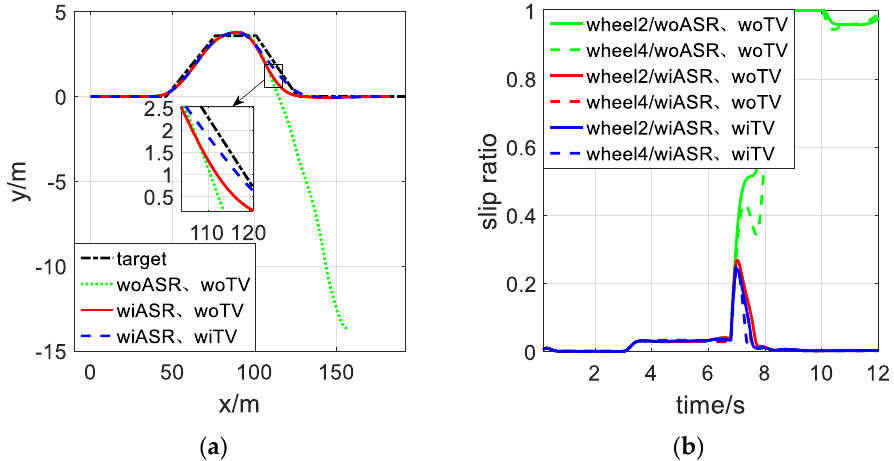
Figure 12. The double lane change maneuvering simulation: ( a ) track; ( b ) tire slip ratio.